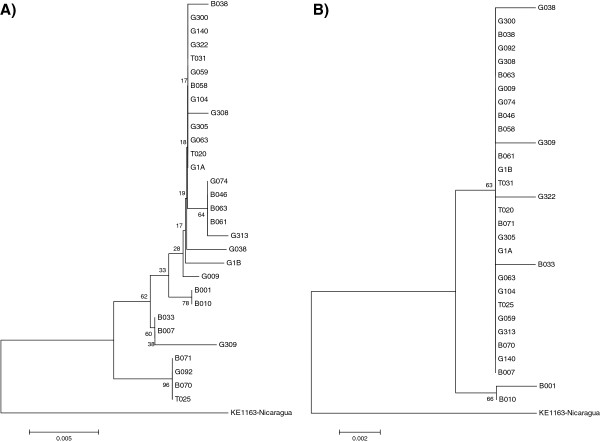
Neighbor joining trees obtained from nucleotide analysis of: A) COI mtDNA and B) cytochromebmtDNA sequences of the 30 Ecuadorian specimens ofNyssomyia trapidoiand one from Nicaragua. Bootstrap values are shown in nodes (500 replicates).